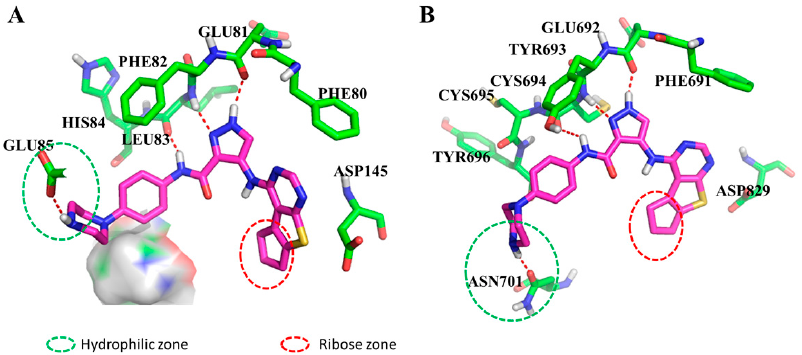
Figure 3. Binding mode analysis of compounds 8t in CDK2 ( A , PDB code 2VU3) and FLT3 ( B , homology model).